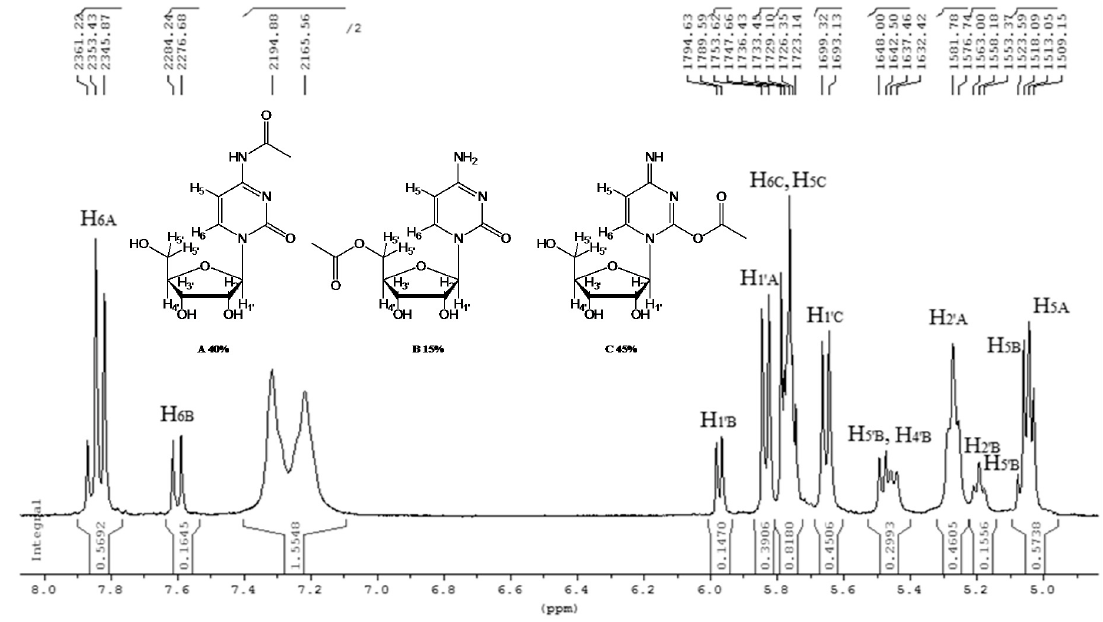
Figure 1. 1 H-NMR spectrum of the crude product obtained from cytidine Figure 1. 1 H ‐ NMR spectrum of the crude product obtained from cytidine acetylation.